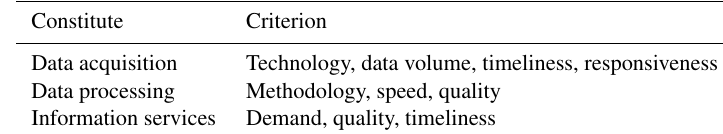
Table 2. Indexes for evaluation of emergency service capacity.